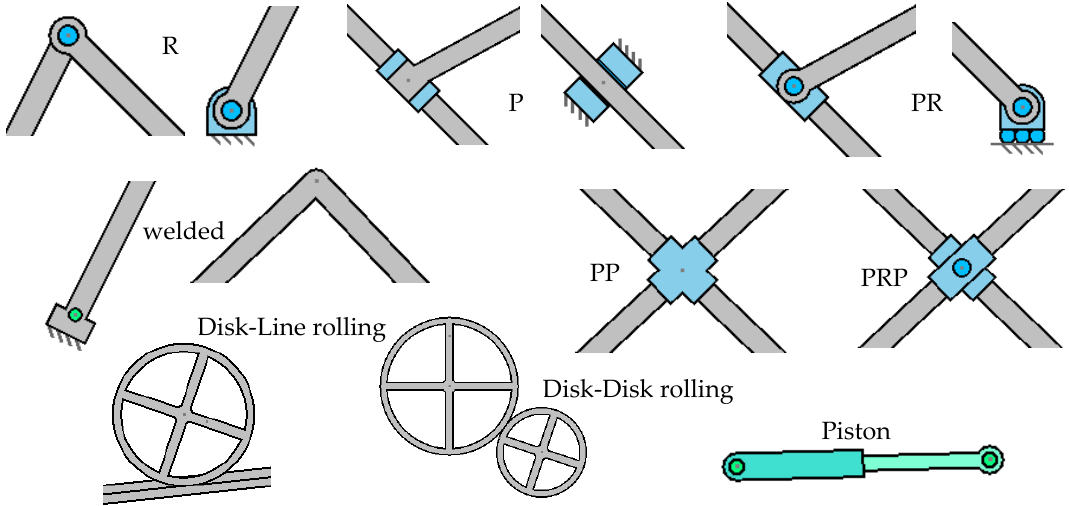
Figure 3. Planar joints implemented in GIM.